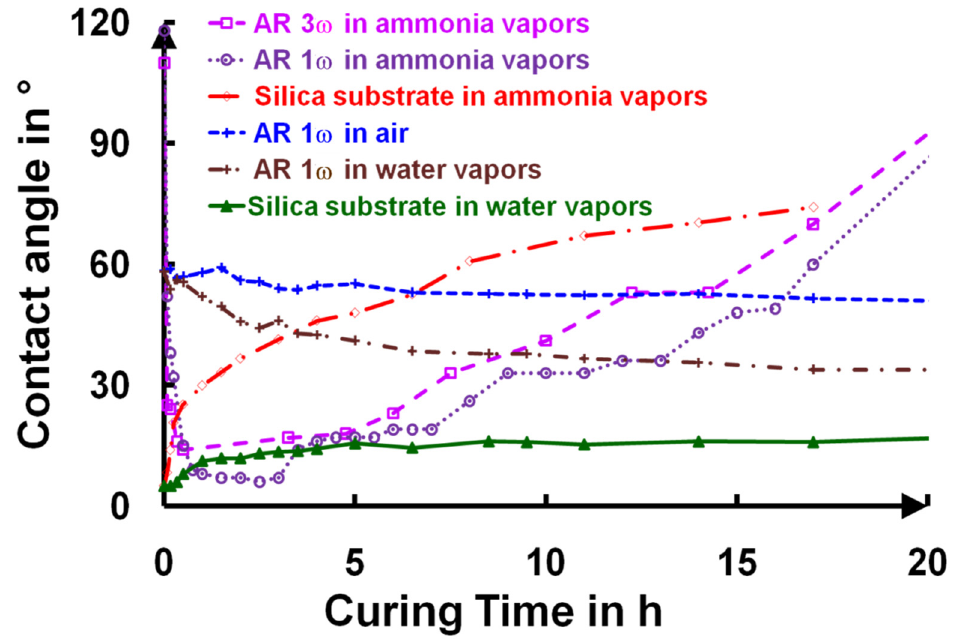
Figure 14. Change in the water-drop angle as a function of NH 3 curing times for two different thicknesses and water vapor exposure times. All presented measurements were conducted in air at room temperature (T = 20 ◦ C ± 0.5 ◦ C) and controlled humidity (RH = 45% ± 5%).